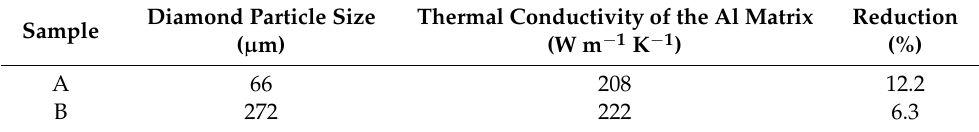
Table 2. Calculated thermal conductivity of the Al matrix after thermal cycling.